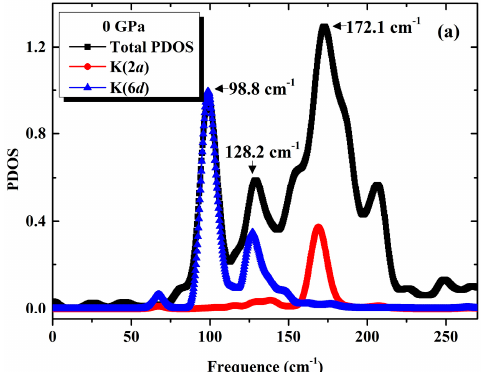
Figure 2. The phonon dispersion relation of K 8 Si 46 at ( a ) 0 GPa; ( b ) 30 GPa and ( c ) 40 GPa.